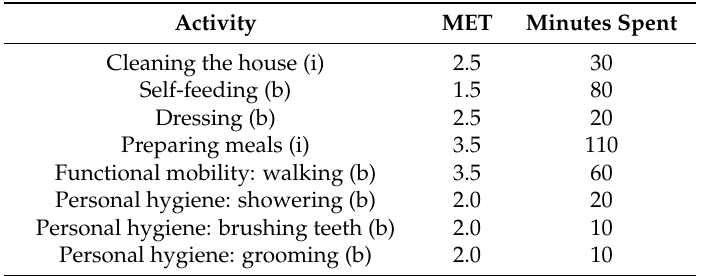
Table 1. Activities and corresponding MET of a hypothetic elder’s